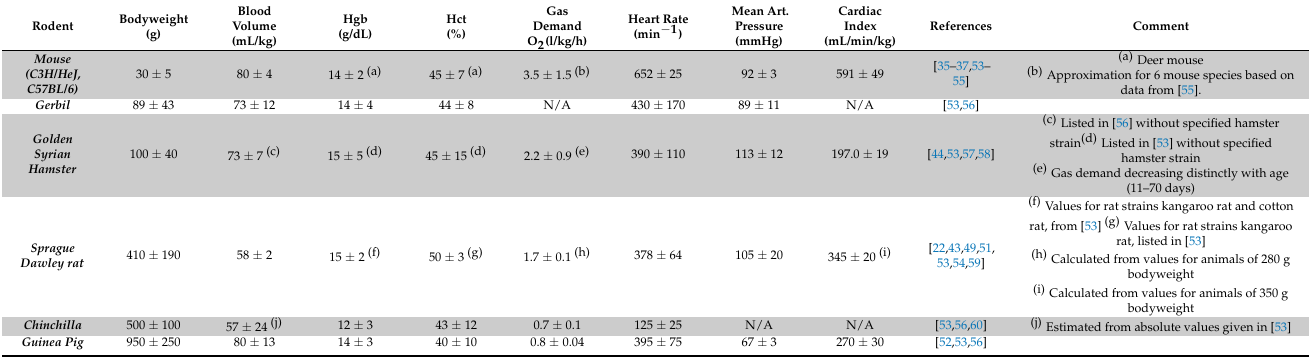
Table 3. Small animals potentially relevant for ECLS modeling with the RatOx oxygenator. The values in this table have been amalgamated both from published studies using the respective animal model (mostly for ECLS or CPB) as well as from textbook reference tables to fill in missing data. The data do not differentiate between sex, age, maturity status, pathology, feeding status, and, in some correspondingly denoted cases, strain. For further reading, excellent overviews of the individual animal were published by Fox et al. [52] and Suckow et al. [53]. Hgb: hemoglobin; Hct: